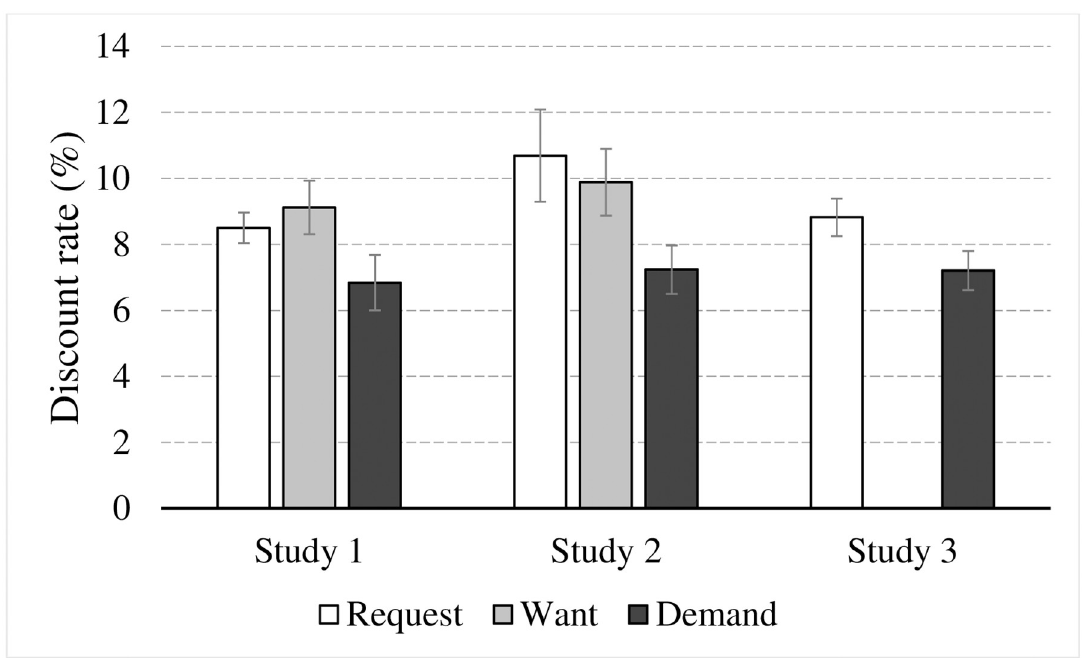
Fig 1. Averaged discount rate as a function of the language used to request a discount in all three experiments. Vertical lines depict standard error.